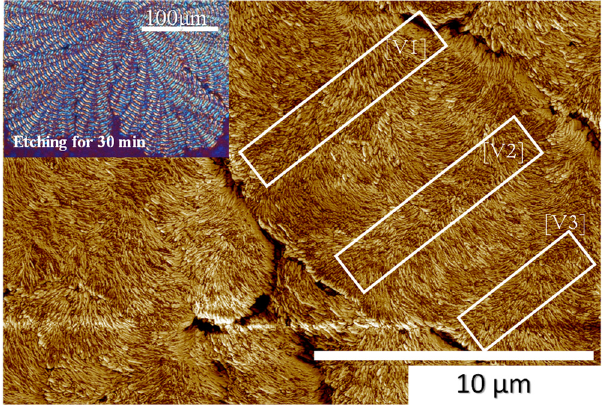
Figure 8. AFM zoom-in phase images (stacked to cover wider regions) for PPDO crystallized from PPDO/PVPh (80/20) at T c = 80 °C. (POM inset on upper-left corner).